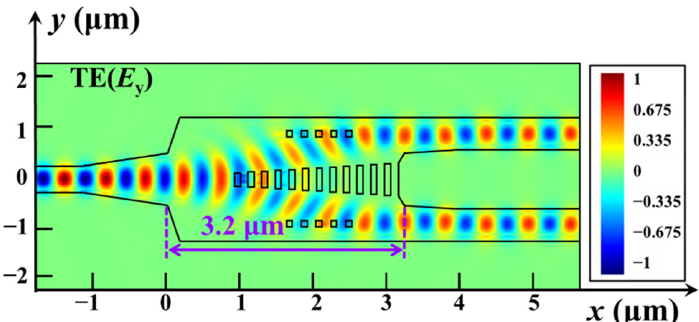
Figure 10. Electrical field evolution of input fundamental TE 0 mode (dominant component: E y ) along the propagation direction through the proposed device, where the MMI length was 3.2 μ m.